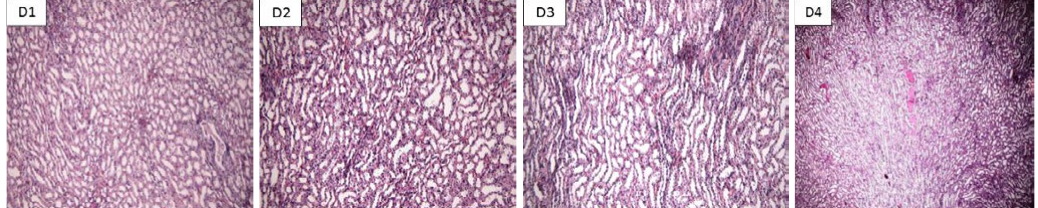
Fig. 5. Photomicrographs of kidney sections obtained from rats exposed to different concentrations of IONs. (D2, D3, D4) control rats received 50, 500, 5000 mg/kg of IONs, respectively (D1, D2, D3): normal kidney, D4: Hyaline casts in kidney (Staining with hematoxylin and eosin). Magnification: 40 x for panels.